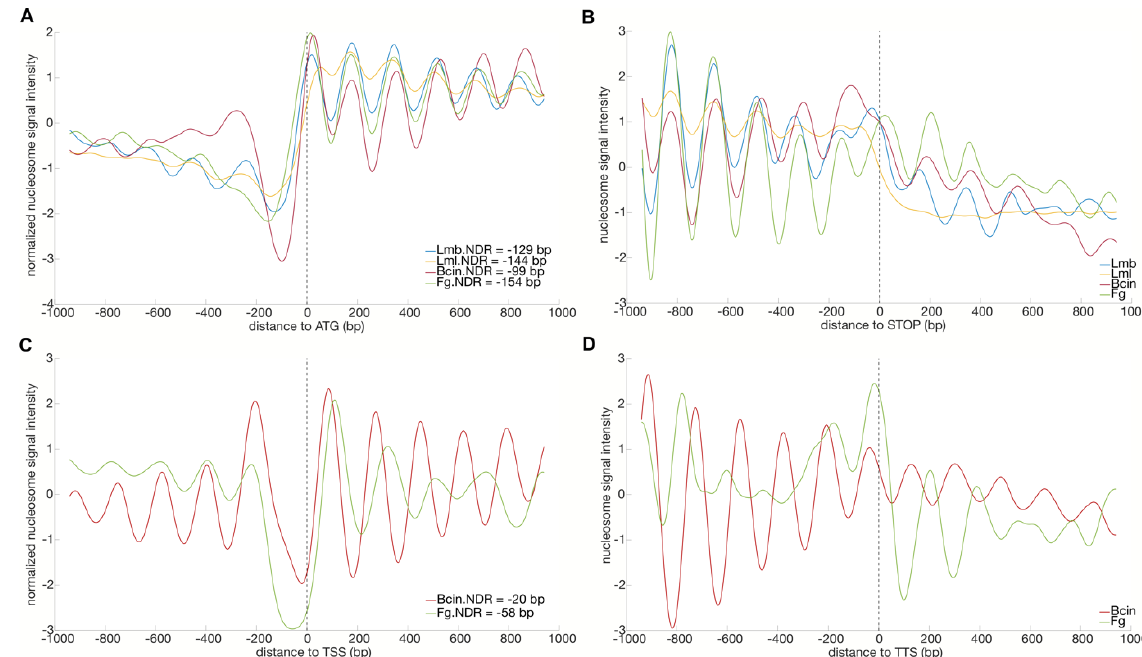
Figure 6: Nucleosome organization of fungal gene units. A-D. Scaled (z-scored) averages (three biological replicates for each fungus/condition) of nucleosome signals as a function of position (in base pairs) relative to the start codon ATG (A), the stop codon (B), TSS (C), TTS (D). Fg = Fusarium graminearum ; Lmb = Leptosphaeria maculans ‘brassicae’; Lml